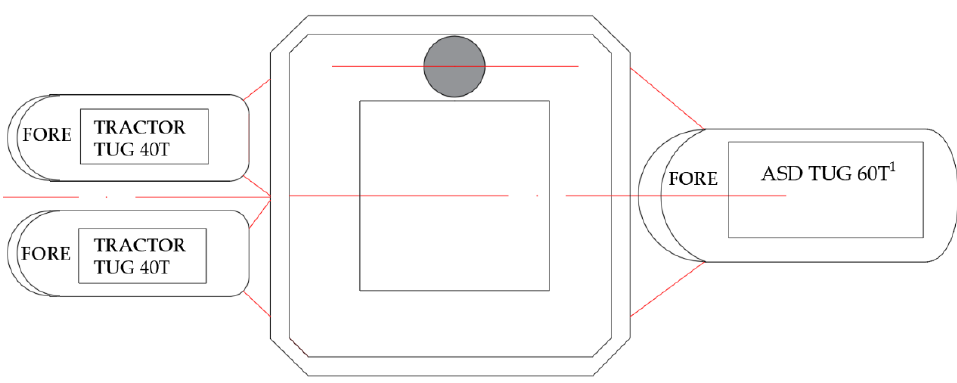
Figure 4. Sea installation stage of the barge-type floating wind turbine. 1 ASD TUG 60T: azimuthing stern-drive tug is a kind of tug that performs towing over the bow, and its weight is 60 tonnes.